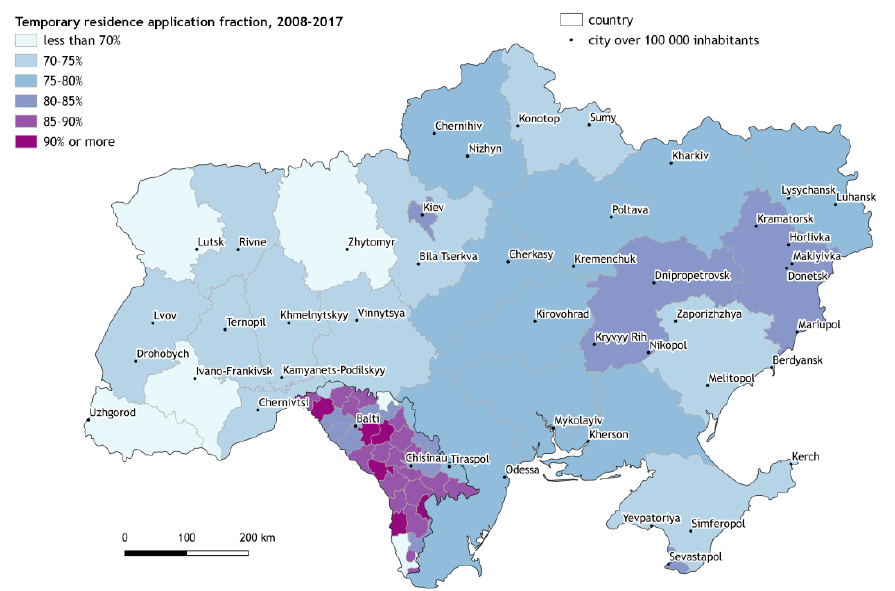
Figure 5. Fraction of temporary residence applications in the immigrant applications for Czechia from Ukraine (by oblast) and Moldova (by raion). Source: our own research.